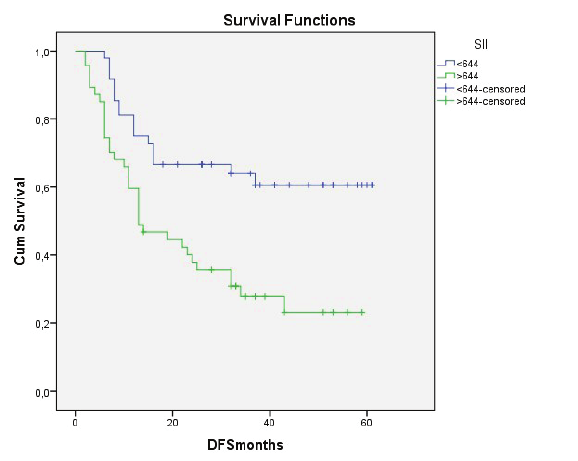
Figure 3b - Kaplan-meier curve for disease-free survival of low and high systemic immune-inflammatory index group